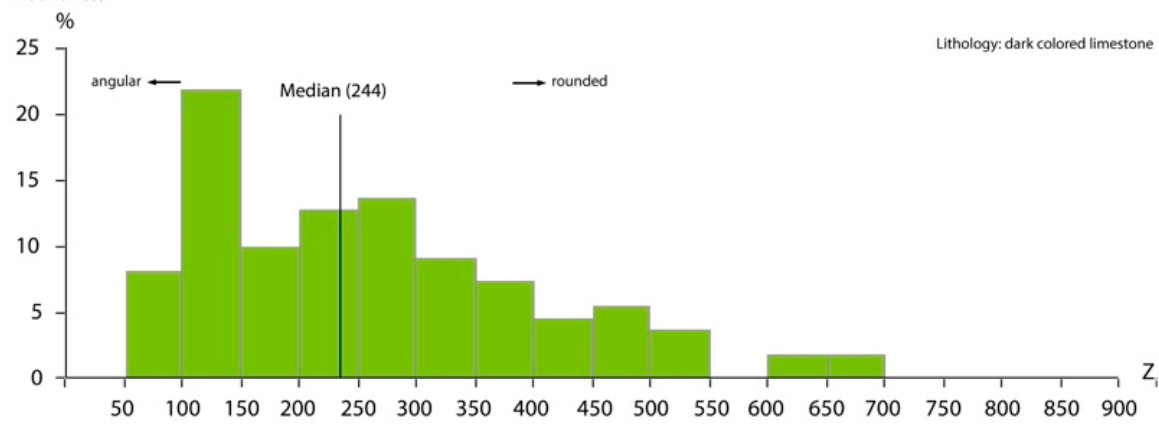
Figure 6. Histogram illustrating roundness index of clasts at the Möhlin site.